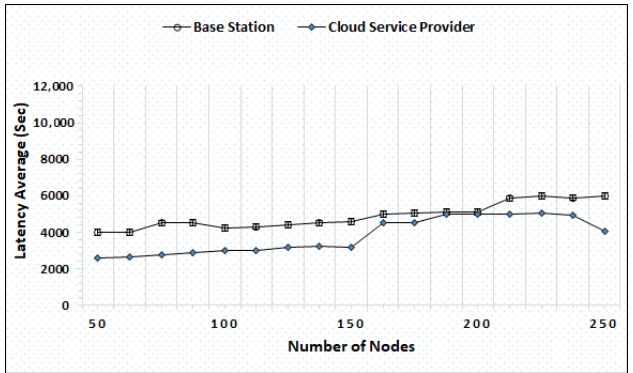
Figure 4. Latency average evaluation by varying nodes.